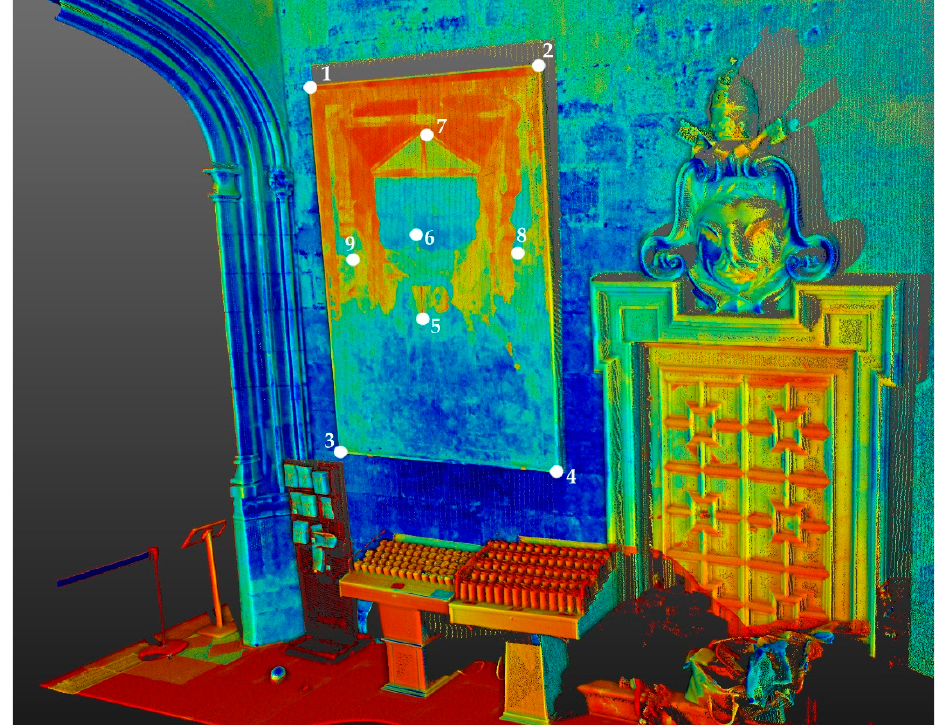
Figure 4. Reflectance image of the TLS point cloud, showing the mural painting and its surrounding situation in the Cathedral of Valencia. The CPs (1–4) and ChPs (5–9) are highlighted in white.